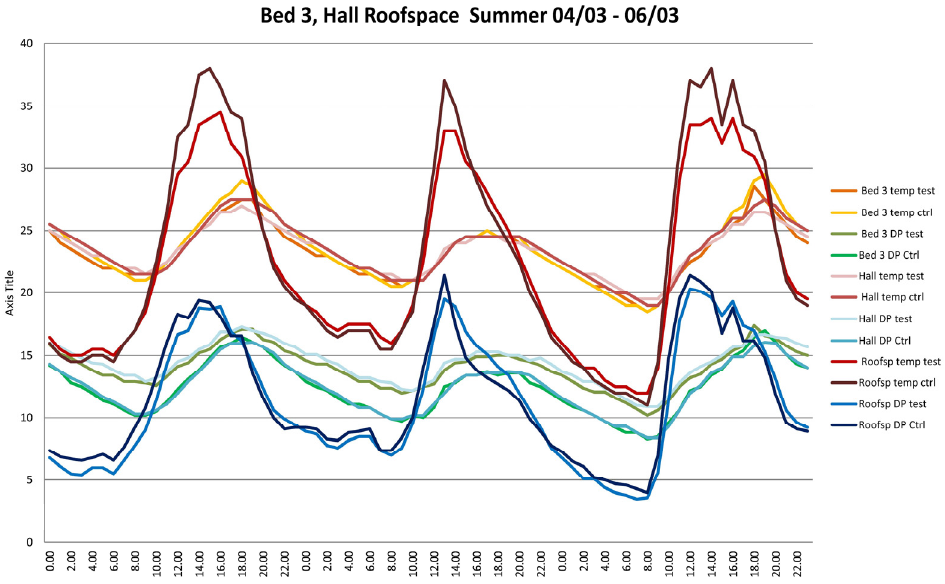
Figure 12. Dry bulb temperatures and dew point comparisons for the bedroom 3 hall and roofspace with external summer